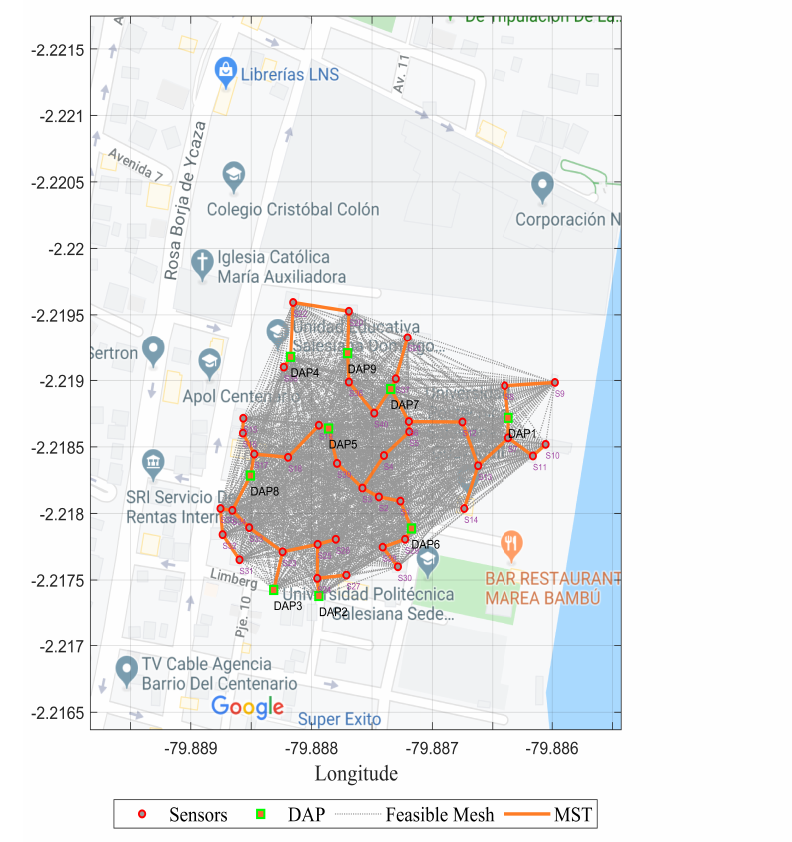
Figure 5. Minimal spanning tree—wireless network backup.